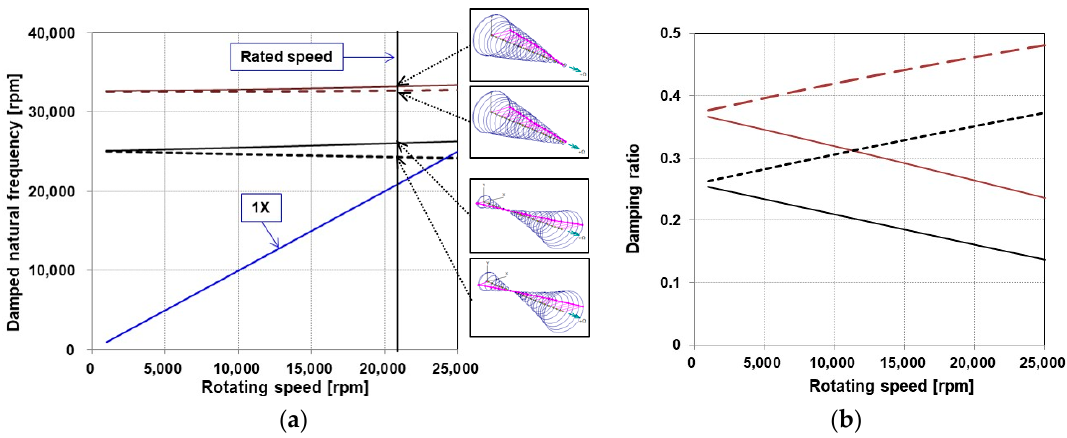
Figure 9. Campbell diagram and damping ratio. ( a ) Damped natural frequency; ( b ) Damping ratio.